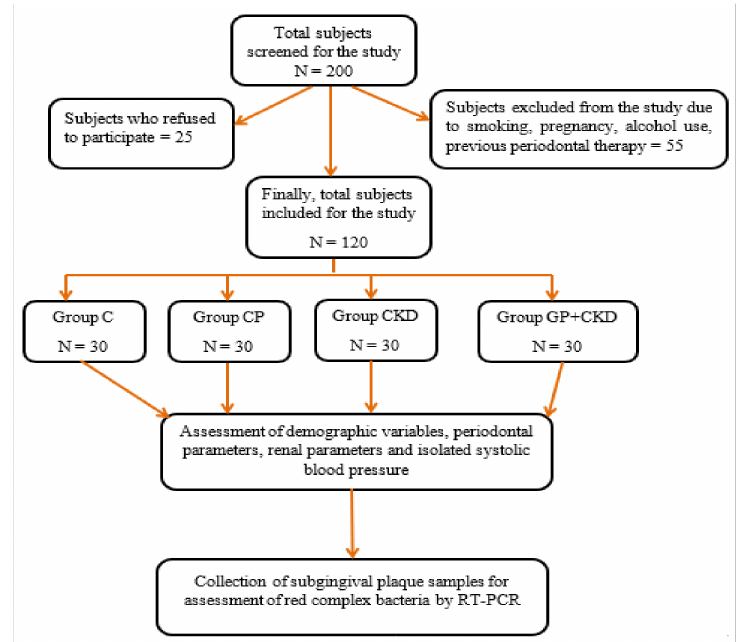
Figure 1. Flow chart of the study